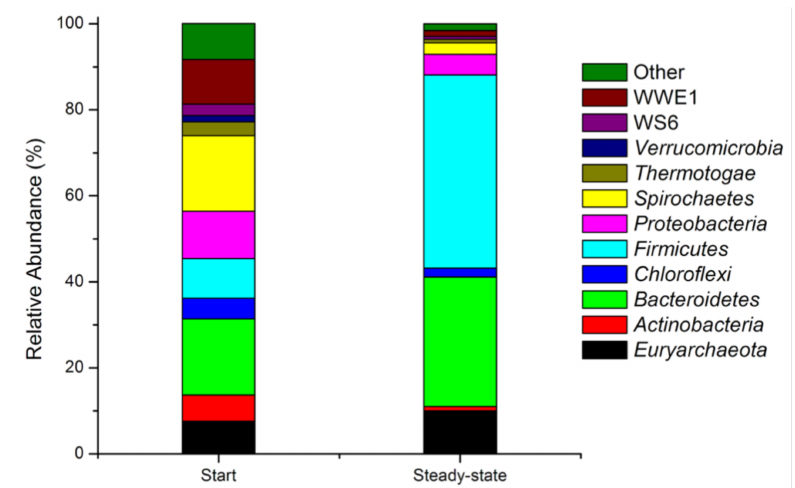
Figure 7. Phyla of microorganisms identified at the beginning and in a steady state of the dark fermentation conducted in a semi-continuous system at the OLR of 5 gVS/(L × d) and the HRT of 10